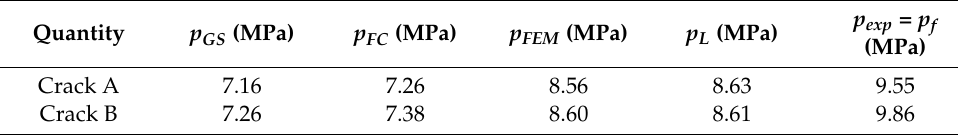
Table 5. Comparison of predicted and experimental fracture